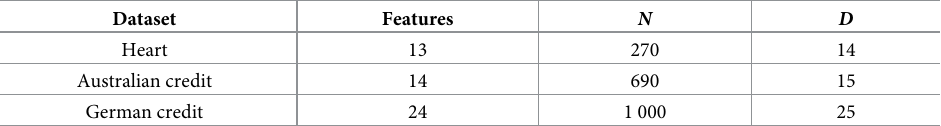
Table 1. Real world benchmark datasets. N represents the number of observations. D represents the number of model parameters.